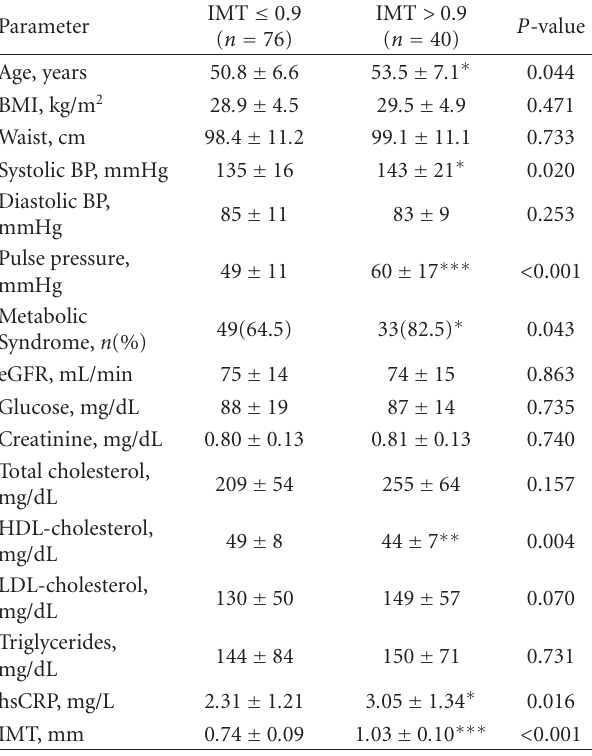
Table 1: Clinical, anthropometric and biochemical characteristics of both groups.